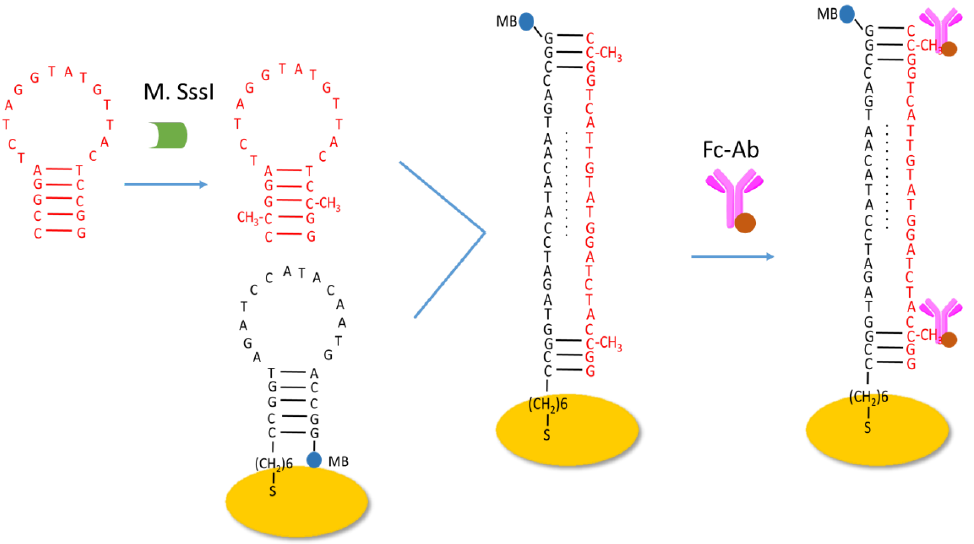
Scheme 1. Schematic illustration of the ratiometric electrochemical biosensor for DNA M. SssI detection.